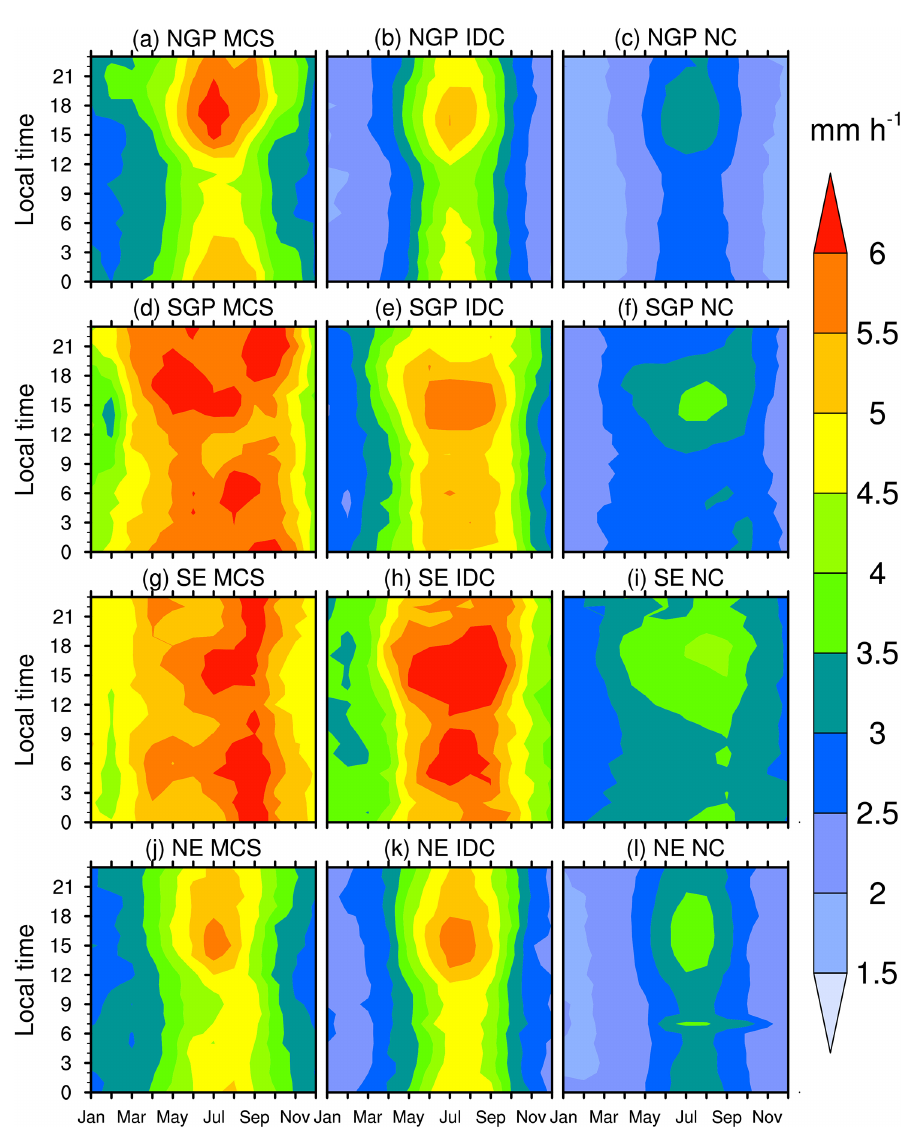
Figure A8. Monthly mean diurnal cycles of precipitation intensities for MCSs (a, d, g, j) , IDC (b, e, h, k) , and NC (c, f, i, l) in the NGP (a, b, c) , SGP (d, e, f) , SE (g, h, i) , and NE (j, k, l) during 2004–2017.